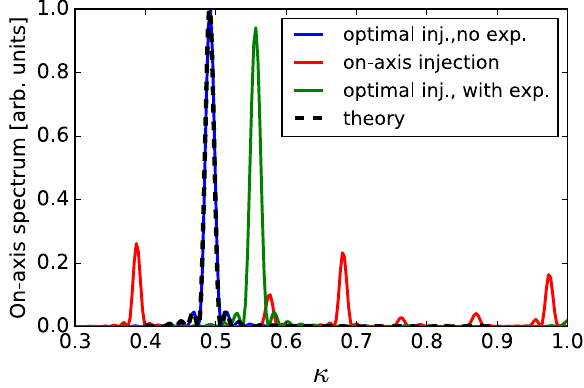
FIG. 4. Normalized on-axis single electron radiation spectrum (in arbitrary units) as a function of normalized photon energy κ for the case of a plasma undulator with N u ¼ 30 . The blue curve corresponds to the case of optimal injection with the exponential term in Eq. (18) neglected. The black dashed line shows the analytical expression Eq. (33). The red curve corresponds to the case of on axis injection with no initial electron transverse momentum, with the exponential term in Eq. (18) neglected. The green curve is the on-axis radiation spectrum of the electron injected optimally into the plasma undulator with the exponential term in Eq. (18)